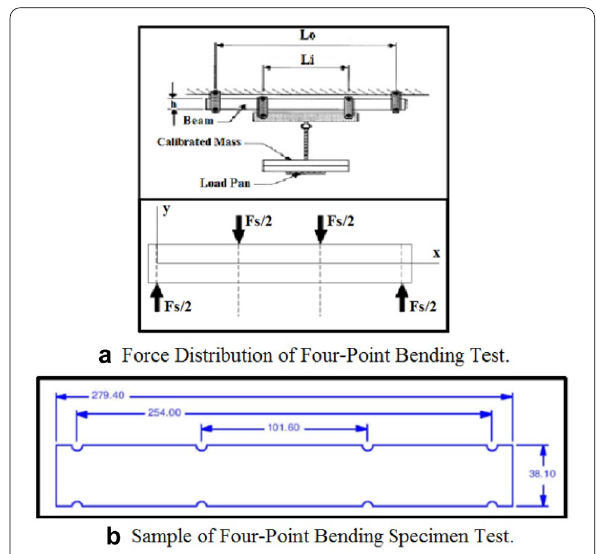
Figure 12 Visualization of forces and ASTM dimensions in a straight beam subjected to four-point bending test